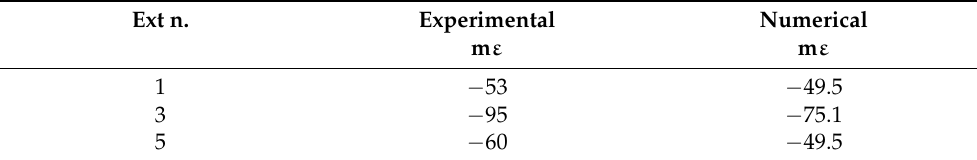
Table 8. Experimental strain at the maximum load along with the numerical strain in case of the wind load evaluated for a selected list of strain gauges. Ext n.